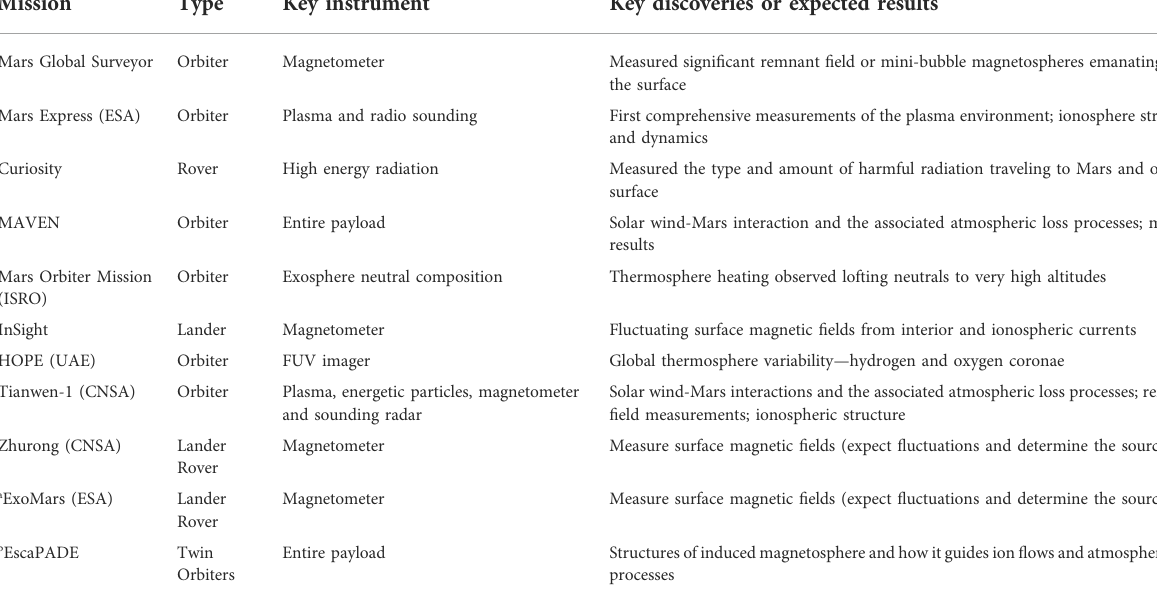
TABLE 1 Past, current, and near-term Mars missions with space weather relevant